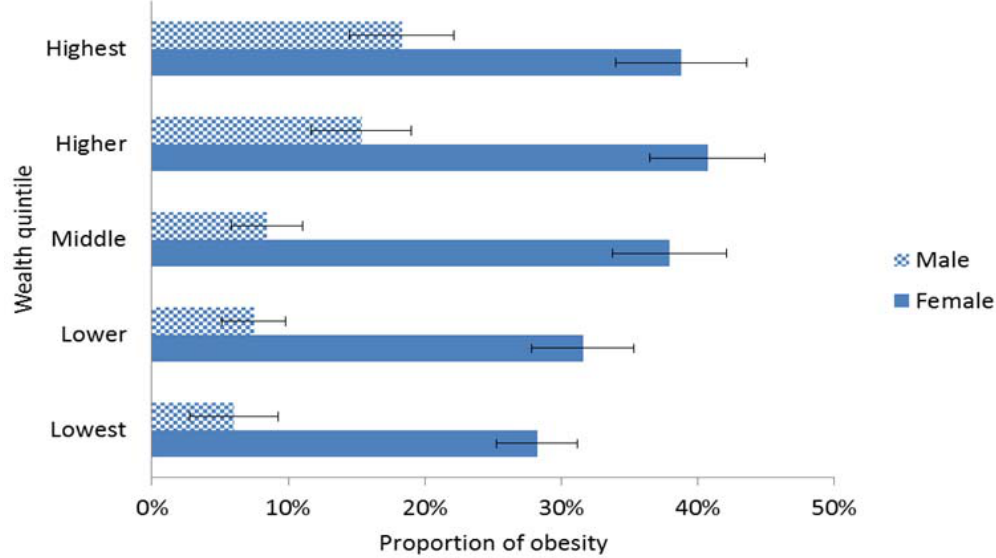
Note: The error bars in Figure 1 represent 95% confidence